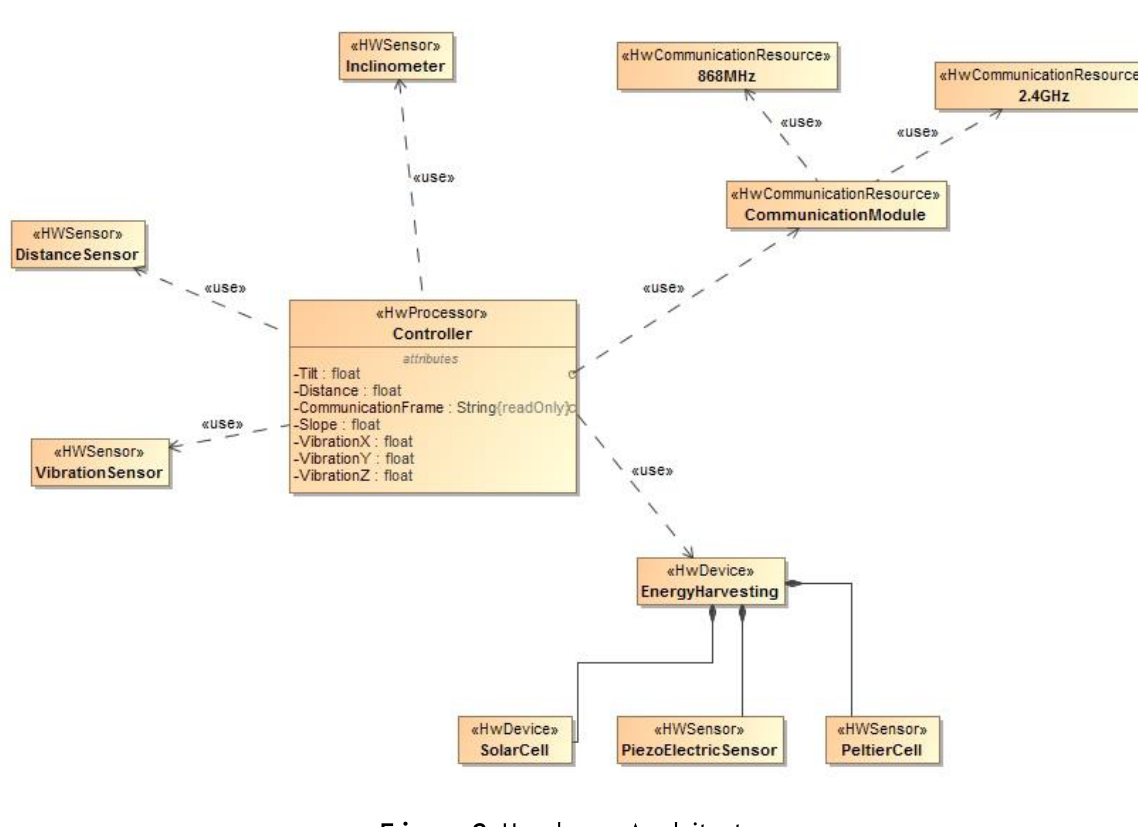
Figure 2. Hardware